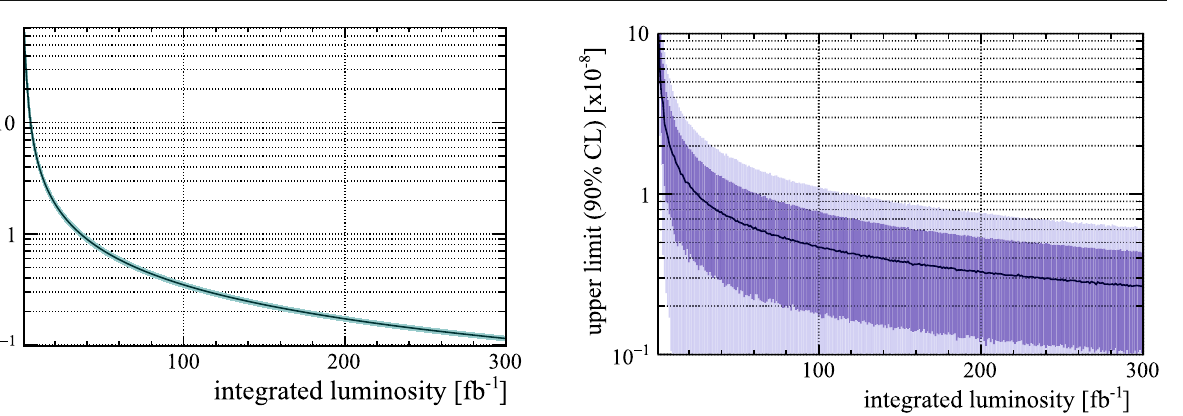
Fig. 2 Expected single-event sensitivity for D ∗ 0 produced in B − → D ∗ 0 π − decays as a function of the integrated luminosity of the LHCb data set